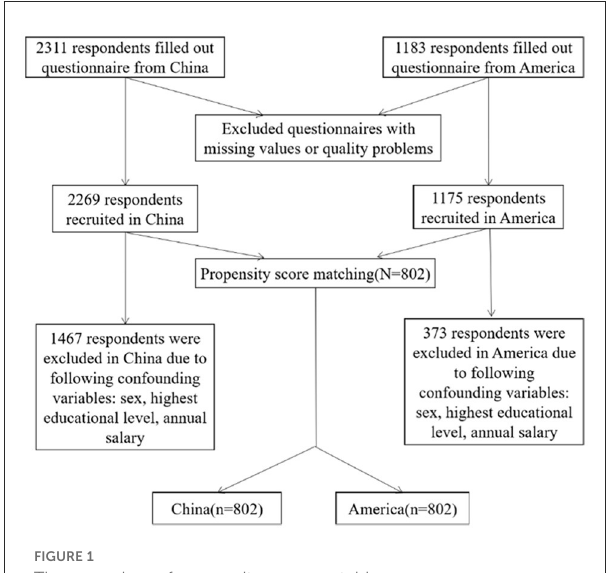
FIGURE1 The procedure of propensity score